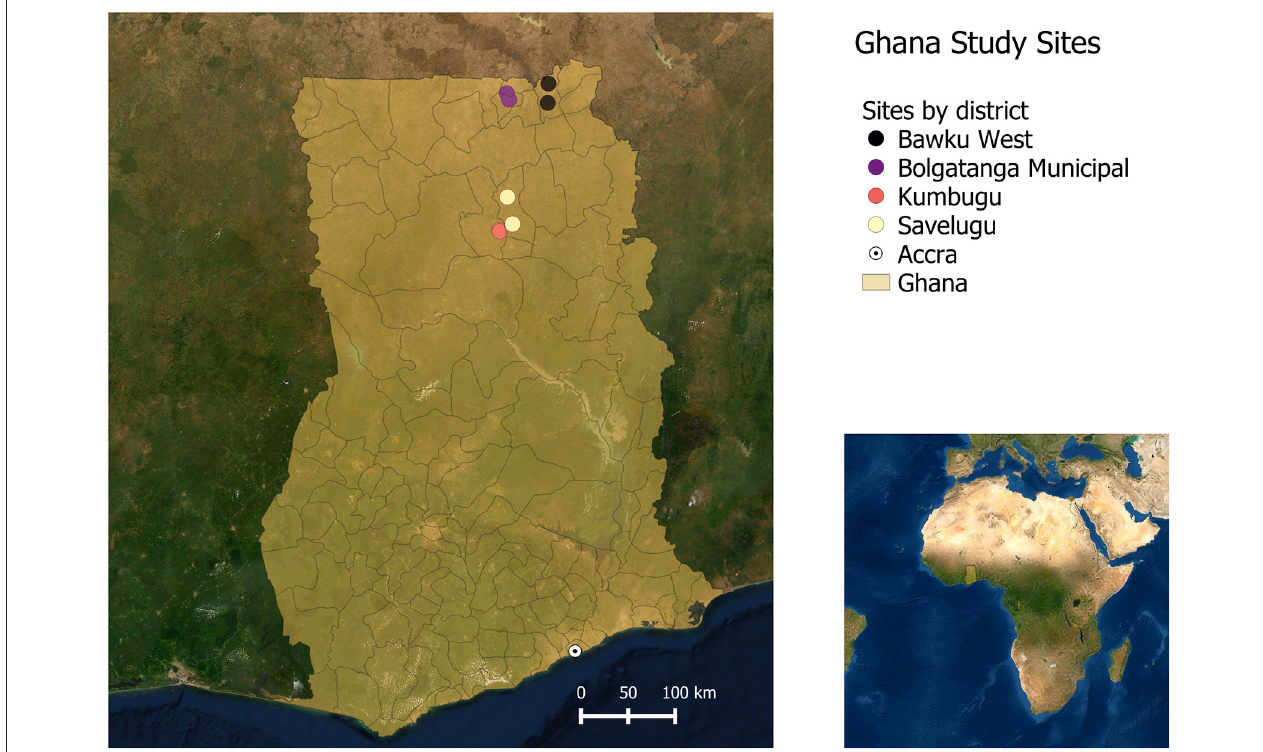
FIGURE 2 | Study sites in